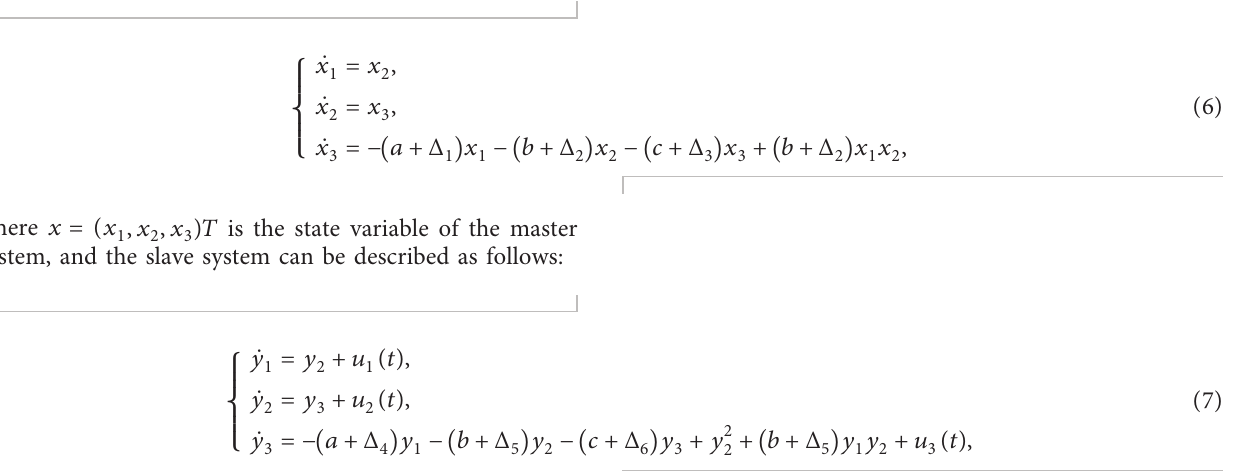
Figure 3: Periodic 1, 2, or 4 orbit of 3D jerk system (1) and projection in x c � 4. (b) a � 3: 34, b � 1, c � 4. (c) a � 3: 36, b � 1, c �